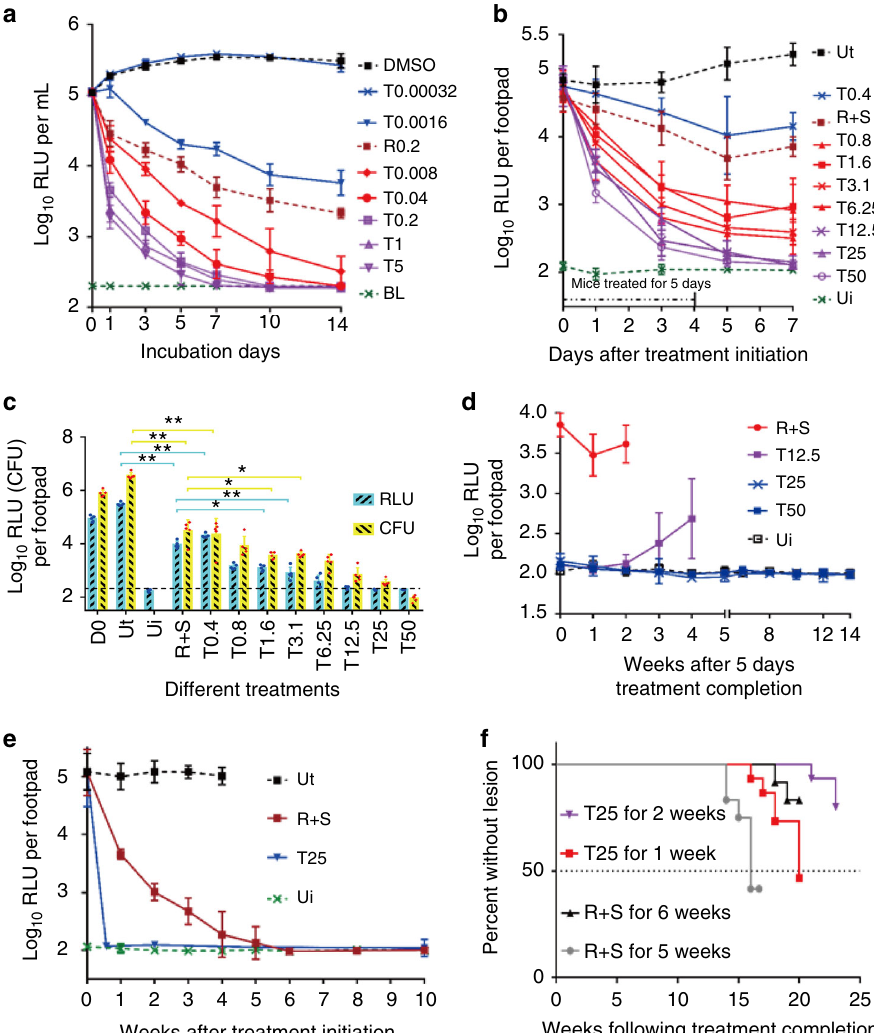
Fig. 1 Activity of TB47 (T) against M. ulcerans . a Time-killing curves of TB47 against AlMu in liquid culture. Concentrations ( μ g mL − 1 ). Data are expressed as mean ± SD from three independent biological repeats. The experiment was performed in triplicate (three independent experiments) and the representative results are shown. b – d Mice were treated from 12 days post infection of AlMu (ALI = 1.09 ± 0.28). Data are expressed as mean ± SD of fi ve samples. b RLUs detected from left hind footpads of the same batch of live mice treated for 5 days and stopped for 3 days. Statistical analysis was performed using unpaired Student ’ s t -test. c RLUs and CFUs of footpad tissue suspension at day 0 and day 7. The experiments for b , c were performed in triplicate (three independent experiments) and the representative results are shown. The correlation coef fi cients ( R 2 ) of RLU and CFU for the in vivo experiments were 0.966 (including the positive) and 0.898 (TB47 treated groups only), respectively. Correlation analysis was performed using Pearson ’ s correlation test. The linearity of the relationship of RLU and CFU for the footpad suspension is valid when the CFUs are from 2.5 to 6.2 log 10 CFU mL − 1 . Statistical analysis was performed using unpaired Student ’ s t- test, * P < 0.001; ** P < 0.0001. d Footpad RLUs detected after completion of treatment for monitoring relapse. e Kinetic curves of RLUs from the footpads of live mice treated with different regimens. Data are expressed as mean ± SD of fi ve samples. f Time to footpad swelling after completion of antibiotic treatment. Time to footpad swelling in mice treated with either rifampin + streptomycin for 5 weeks (gray circles) or 6 weeks (black triangles), or TB47 for 1 week (red square) or for 2 weeks (purple triangle). Statistical differences were determined by Log-rank (Mantel-Cox) test with 15 mice in each group. T, TB47; BL, base line; Ui, uninfected (for RLU detection, Ui is the base line); Ut, untreated; R, rifampin, 25; S, streptomycin, 150; Dosage (mg kg − 1 ). The dotted green lines indicated the base line (the limit of detection). Data are expressed as mean ± SD. * P < 0.001; ** P <